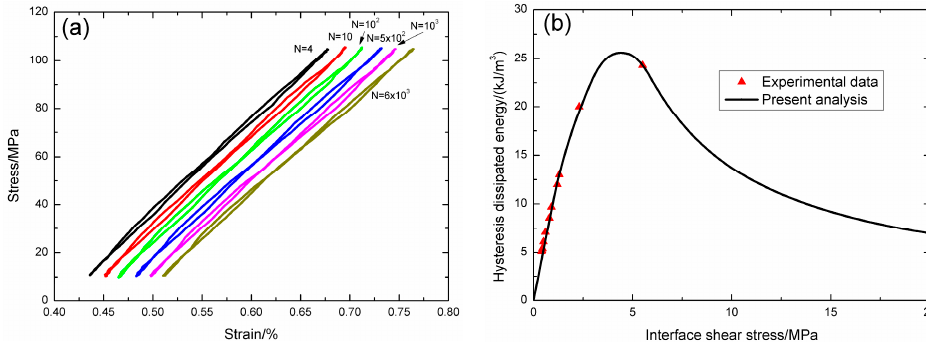
Figure 10. ( a ) The experimental fatigue hysteresis loops corresponding to different cycle number; and ( b ) the experimental and theoretical fatigue hysteresis dissipated energy versus interface shear stress curve of cross-ply C/SiC composite under σ max = 105 MPa at 800 ◦ C in